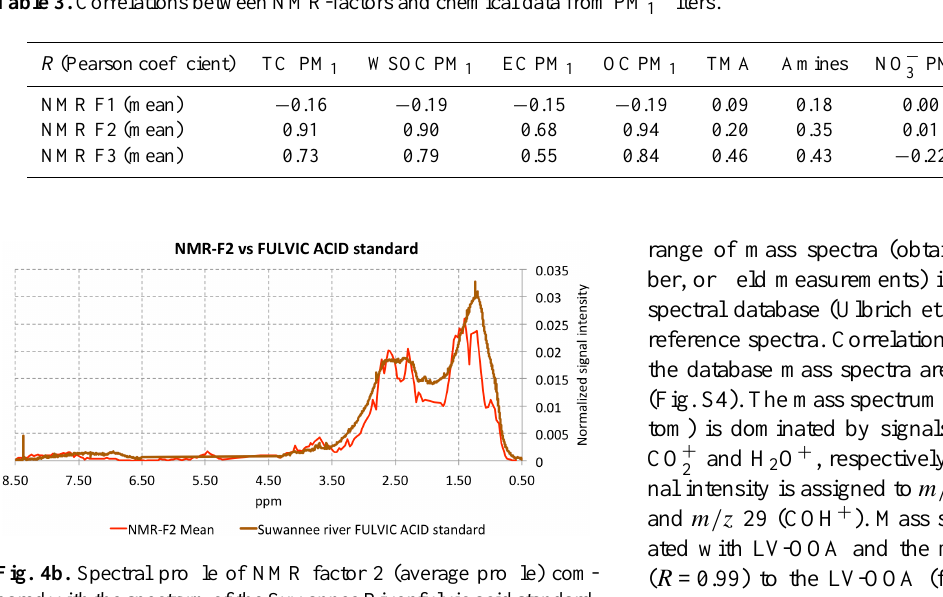
Fig. 4a. Profiles and contributions of 3-factors solution from NMR spectra factor analysis. Results from all five different algorithms and the average between them were reported: PMF from EPA free software (light blue line), projected gradient (red line), multiplicative (yellow line), MCR-ALS (green line) and MCR-WALS (orange line) methods and average value (with standard deviation bars) for contribution (thick black line in each graph). Table 3. Correlations between NMR-factors and chemical data from PM 1 filters.